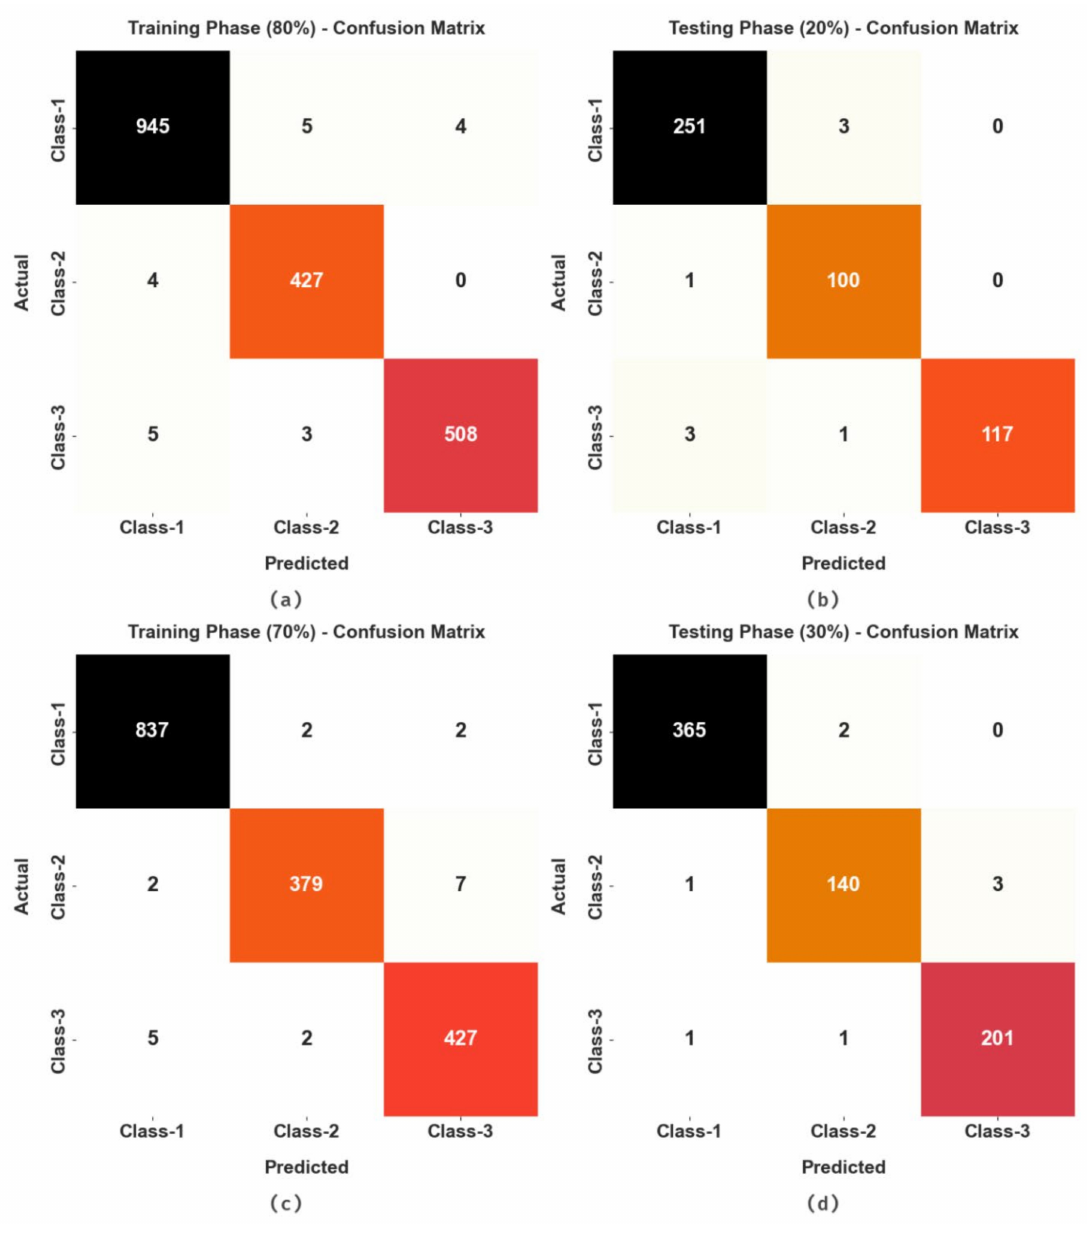
Figure 4. Confusion matrices of MRFOTL-GCDC system ( a , b ) TR and TS database of 80:20 and ( c , d ) TR and TS database of